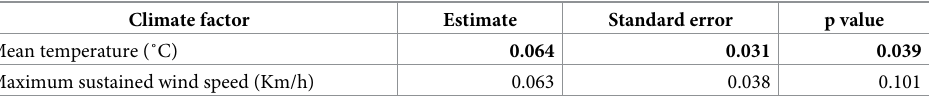
Table 6. Multivariable regression analysis of climatic factors associated with murine typhus from country wide case counts, using climate data from Vientiane Capital. Model includes mean temperature and maximum sus- tained wind speed (1,285